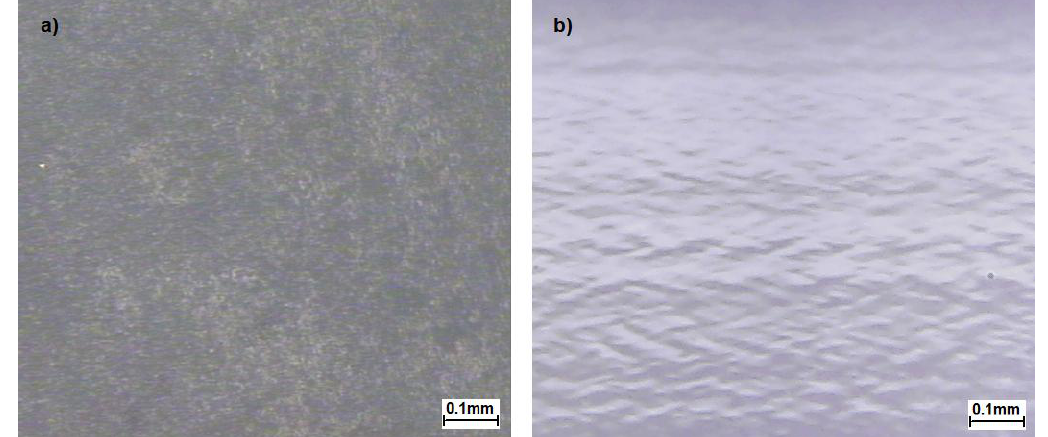
Figure 4. Optical microscopy of ( a ) bulk S-TPU and ( b ) F-TPU filament.